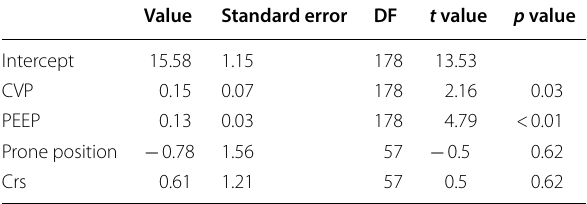
2 pulse oxygen saturation